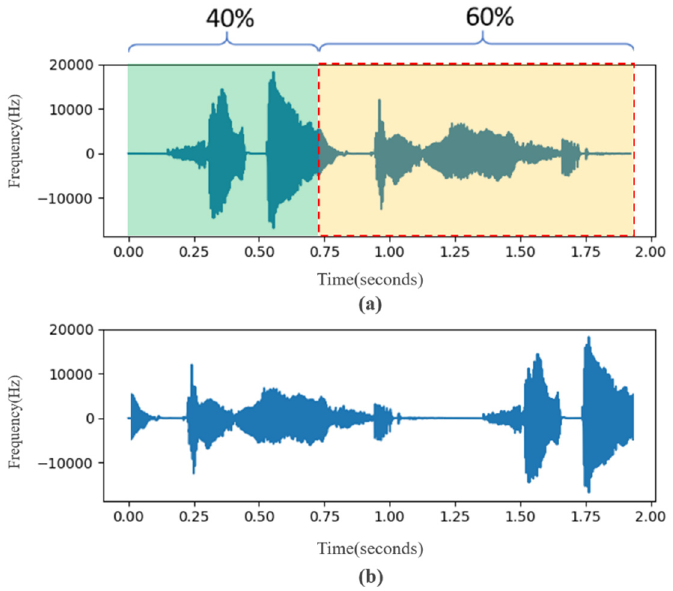
Figure 5. ( a ) Original waveform ( b ) waveform after 60% rotation.